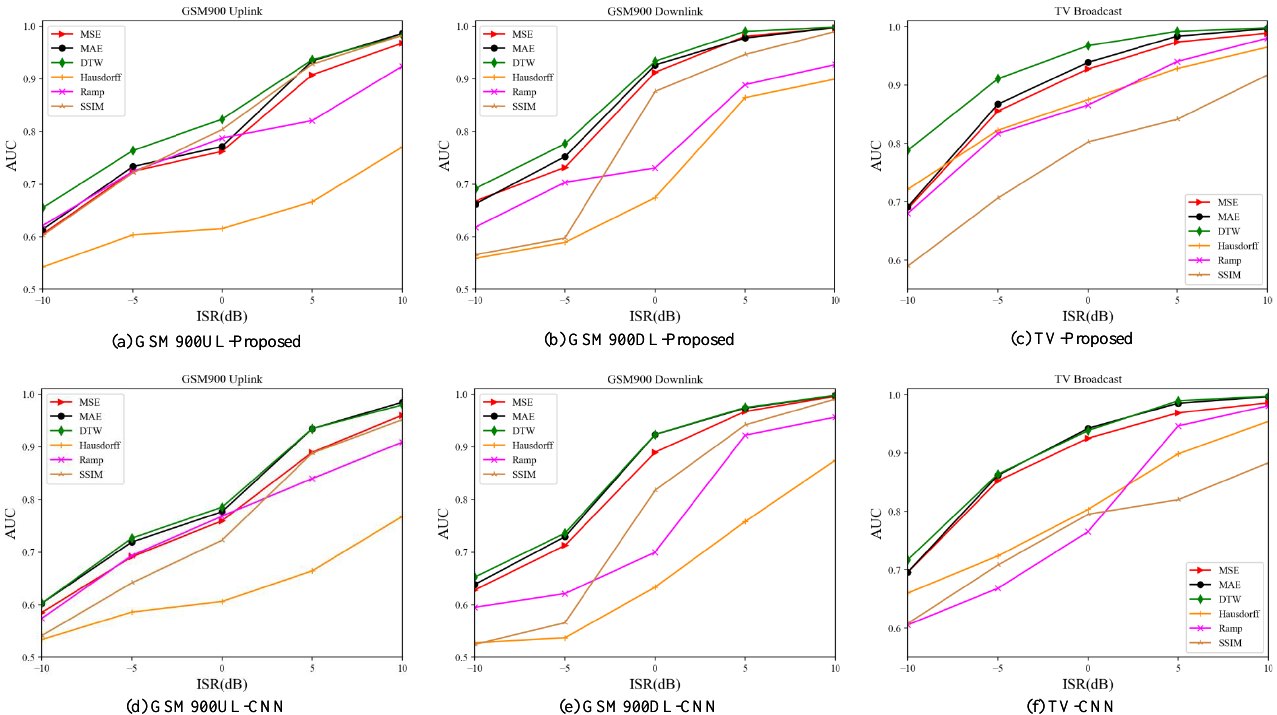
Figure 7. AUC variation of the discriminant